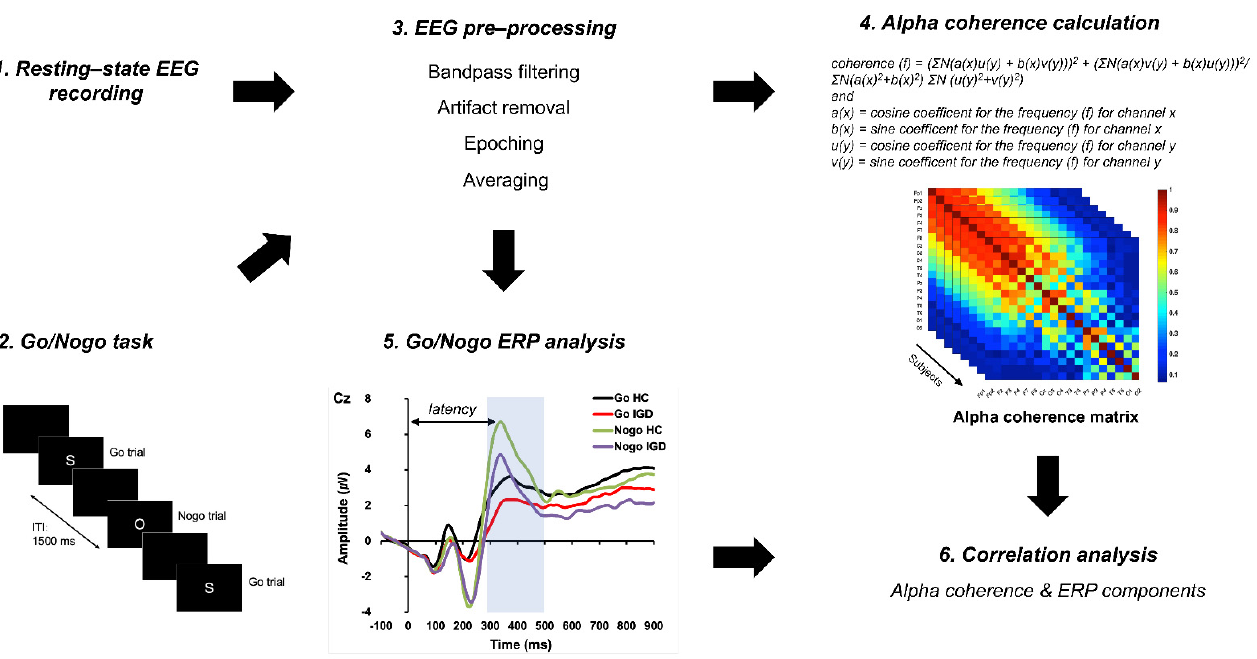
Figure 1. Schematic flow of this study.